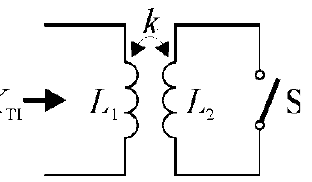
Figure 3. Diagram of the operating principle of a tunable inductive filter.